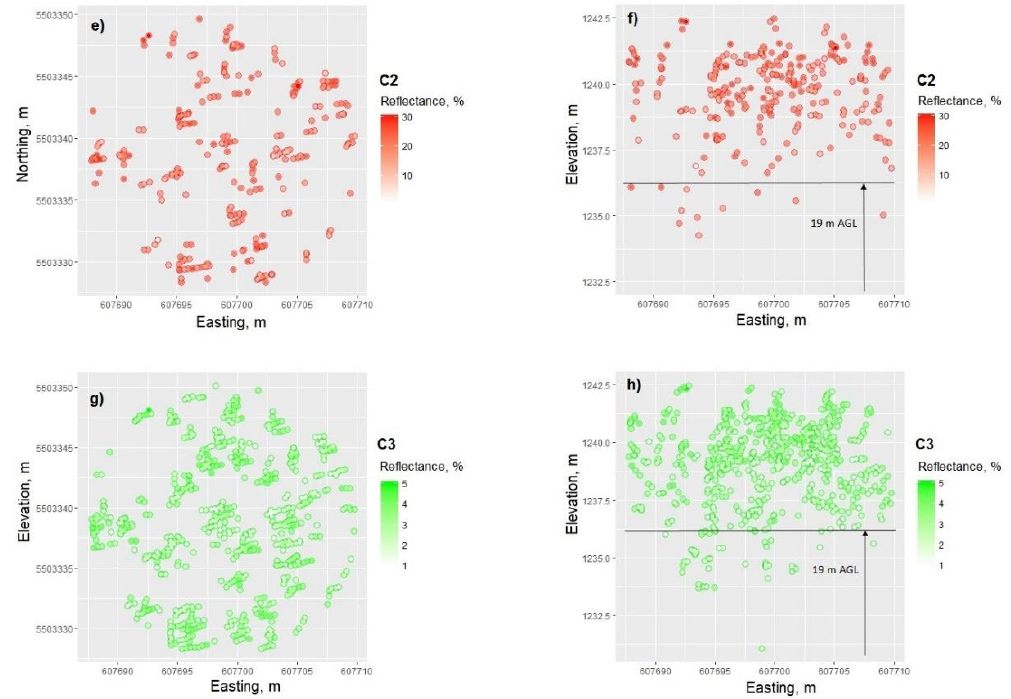
Figure 6. ( a , b ) All channel single returns for the established LP plot canopy combined in one image without intensity information. ( c – h ) Single-return intensities coded with color for the LP plot 1 canopy for all three channels. Cuto ff line at 19 m above ground is shown by black horizontal line in ( b , d , f , h ).